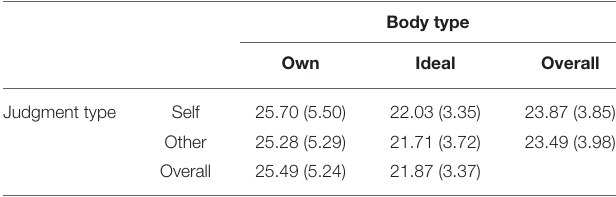
TABLE 1 | Mean BMI estimations for both own and ideal bodies, made during the figure rating scale (self) or the general estimation task (other).